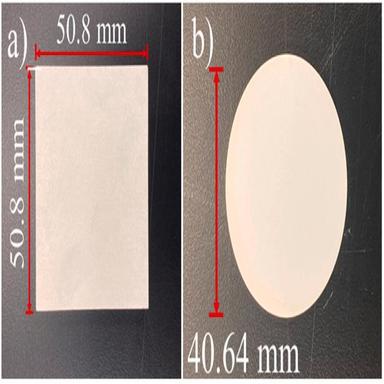
Images of the purchased commercial samples. a) Square sample of 6.35 mm thickness purchased from LSP Industrial Ceramics, Inc. b) Disk sample of 3 mm thickness purchased from Stanford Advanced Ceramics.